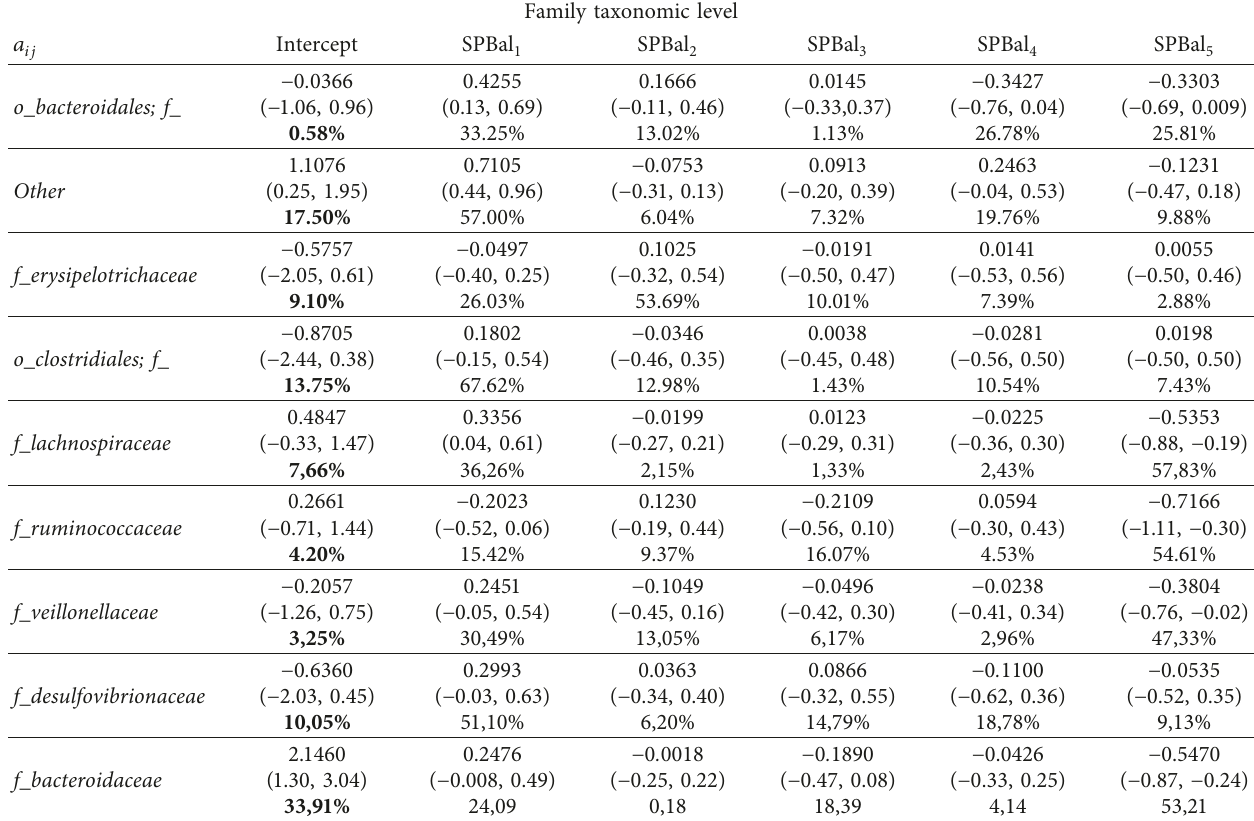
Table 3: Estimated parameters ( a ) and credible interval obtained by applying the proposed model to the female dataset at family ij taxonomic level. The table also contains the percentage of influence that each SPBal j has on each family and the percentage of sway that each family has on the bacterial community is represented in